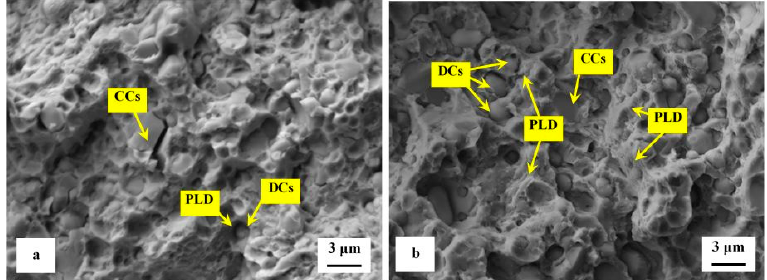
Figure 8. Detailed SEM micrographs of the fracture surfaces of sub-zero treated specimens after flexural strength testing, ( a ) tempered at 170 °C and ( b ) tempered at 600 °C.